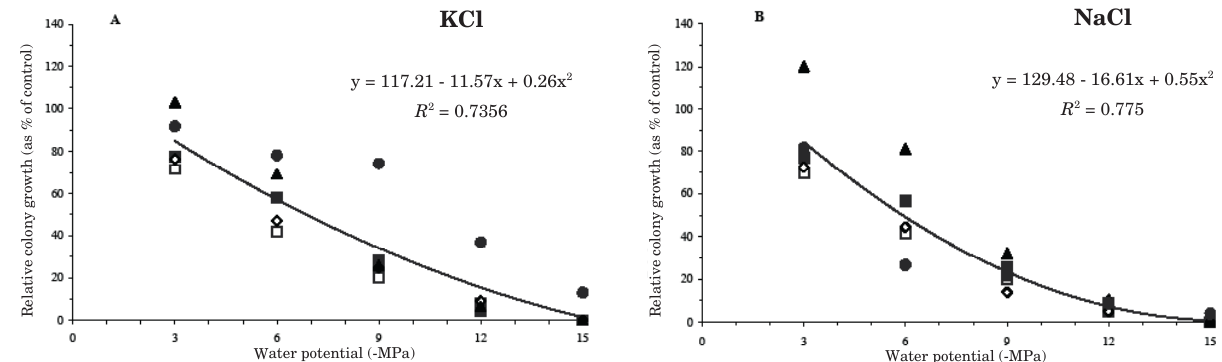
Figure 2. relative colony growth (rCG), averaged over three different times (7, 14 and 21 d) and calculated as percentage of growth relative to that on nonamended medium (-0.34 MPa) of Seiridium cardinale (card 167, n ; card 170, ¨ ), S. cupressi (cup 186, ◊), S. unicorne (uni 237, p ), and Diplodia cupressi (dip 111, l ) grown on PSa modified osmotically with KCl (a) or NaCl